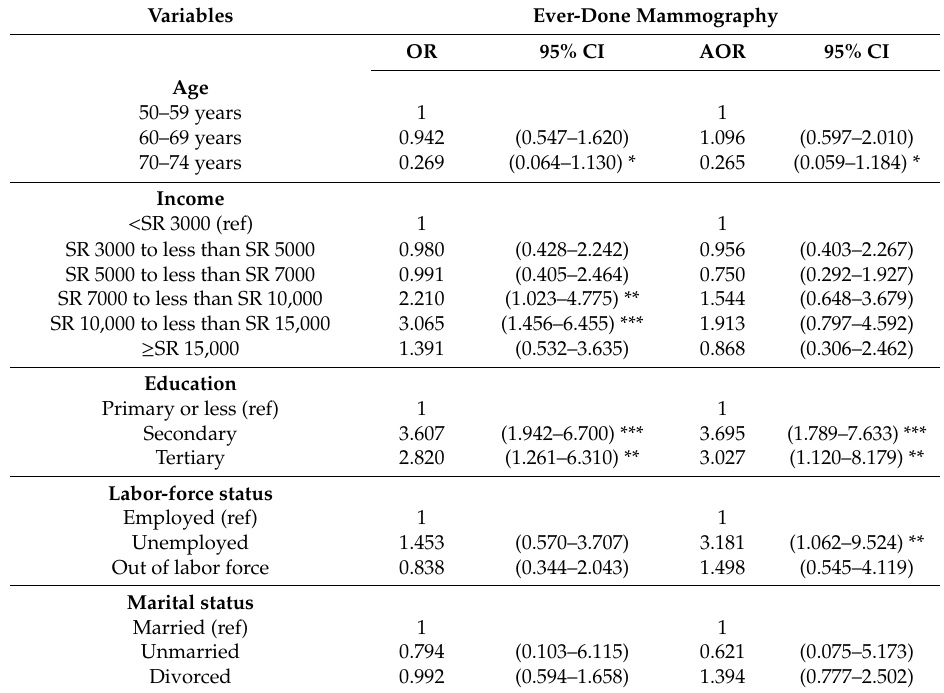
Table A2. Logistic regression results of the correlates of mammography screening (age 50–74, n =